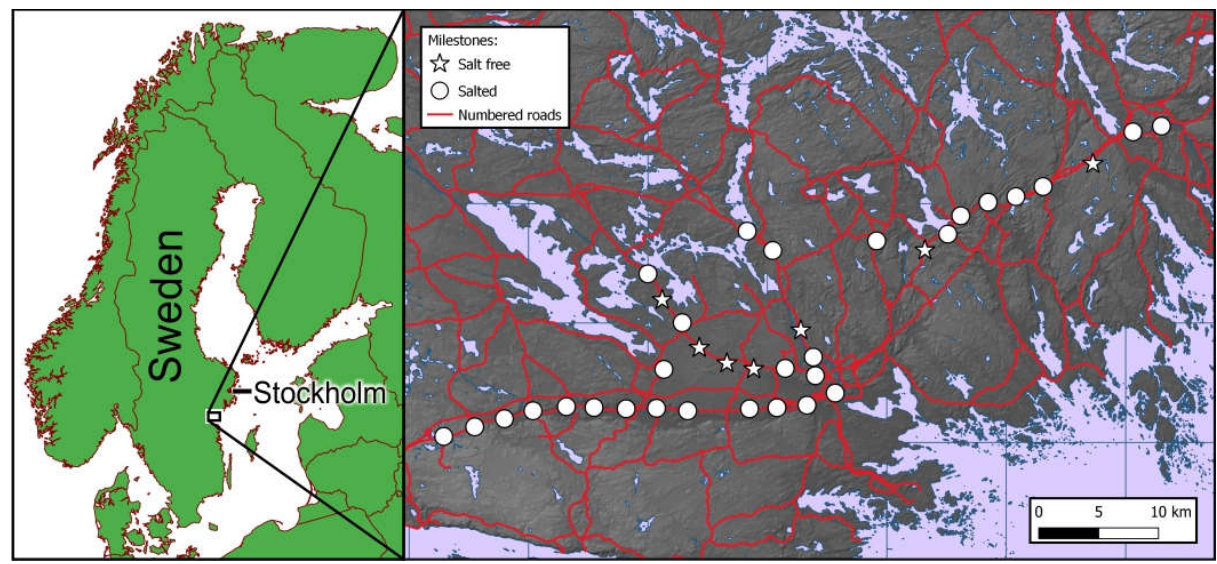
Figure 1. Map of milestones in this study. Circles are on main roads with winter salting, stars are on older stretches of road without through traffic or winter salting (Basemap data ©Lantmäteriet, Sweden).